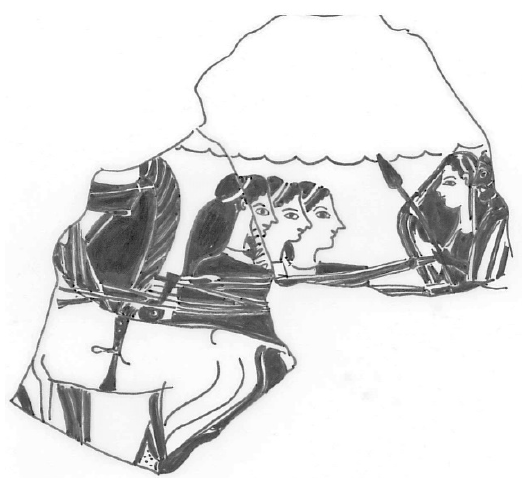
Figure 3. Fragment(s) of a Corinthian column crater. The Hague, Scheurleer Museum inv. 2032–2033. (with a fragment in Copenhagen, National Museum 12.350.). Drawing by the author.